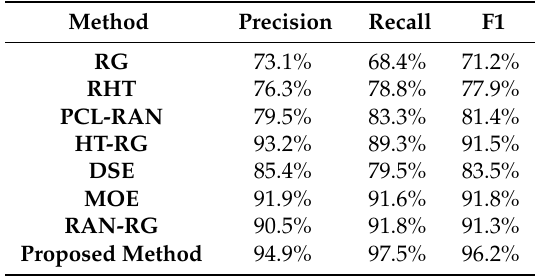
Table 4. Indicators score of